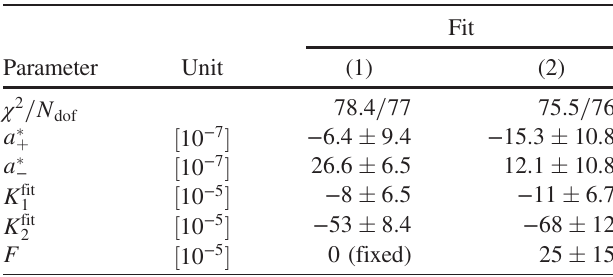
SPIN TUNE MAPPING AS A NOVEL TOOL TABLE VI. Fit parameters of a COSY-I NFINITY simulation using Eq. (71) of the toy model with two tilted solenoids S 1 and S 2 embedded in an otherwise ideal ring.